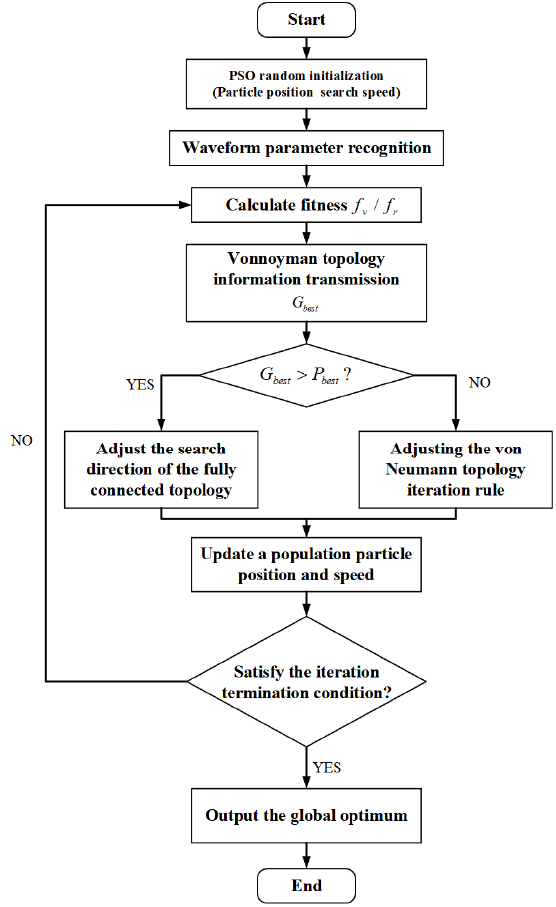
Figure 9. Flow chart of the parallel iterative particle swarm algorithm.